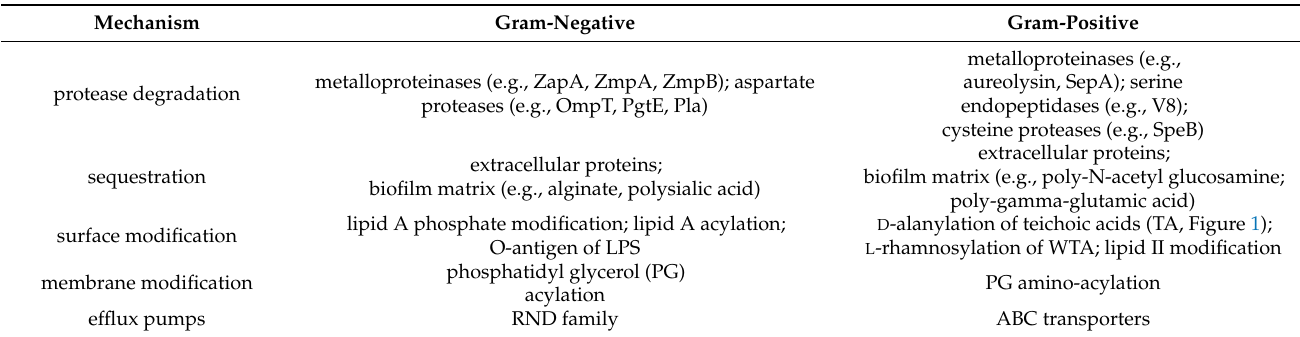
Table 1. Resistance Mechanisms to HDPs for Gram-negative and Gram-positive pathogens. For extensive details on the mechanisms, the reader is invited to consult the excellent reviews of Mookherjee et al. [40] and Joo et al. [30]. Mechanism protease